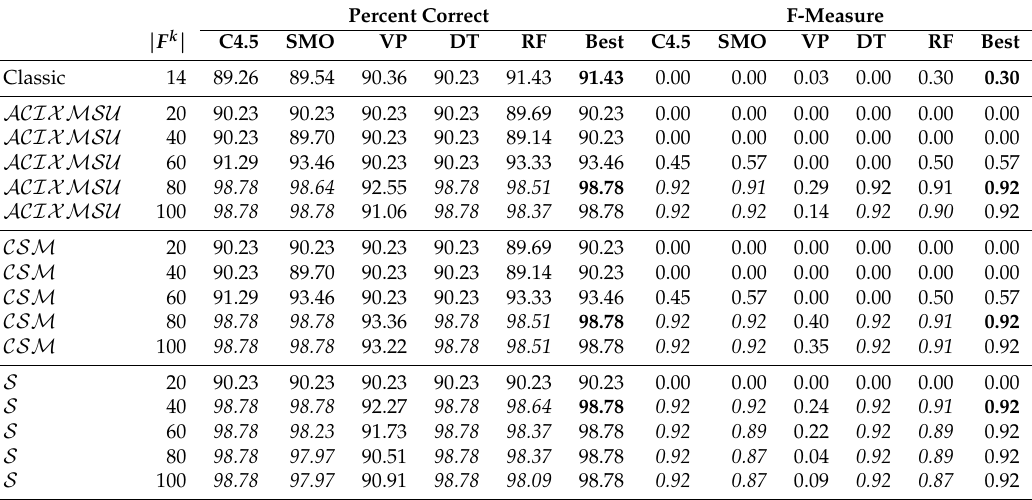
Table 6. “Go to bed” classification performance.